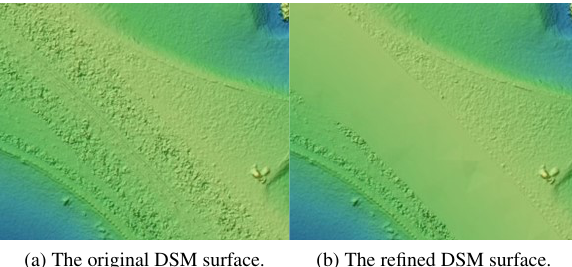
Figure 15. With the reconstructed lane-lines, the DSM quality on road surfaces is